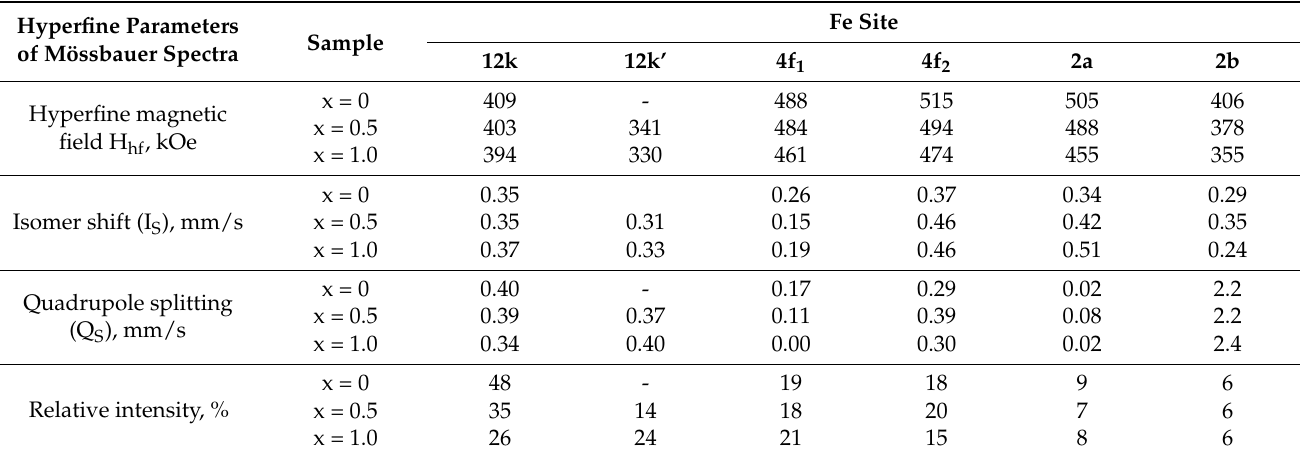
Table 2. Mössbauer spectra parameters of samples SrFe 12 − x In x O 19 after mechanochemical synthesis and annealing at 1200 ◦ C, 1 h.